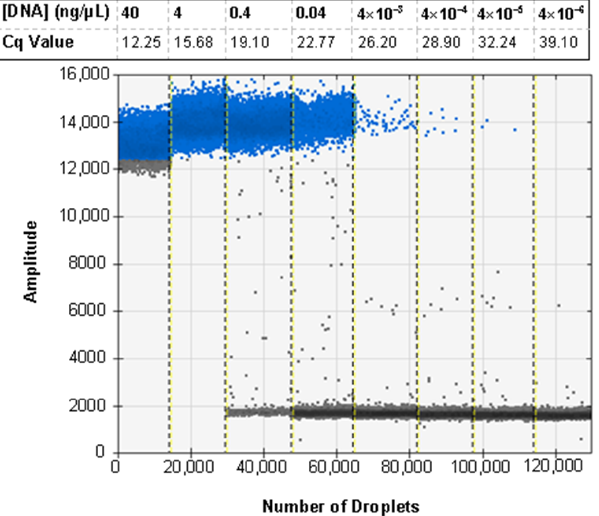
Figure 4. The ddPCR assay using EvaGreen is sensitive and able to detect H. armigera DNA to 4 × 10 − 5 ng/reaction. For comparison, the average Cq value for 6 technical replicates of the real-time PCR sensitivity assay is shown corresponding to the data presented in Figure 1. Positive droplets are shown in blue, and negative droplets are shown in grey apart from the lane marked 40 in which the grey droplets at the bottom of the positive cluster are likely falsely marked as negative due to the lack of a cluster of negative droplets in the well. This indicates that the assay is oversaturated with target DNA.